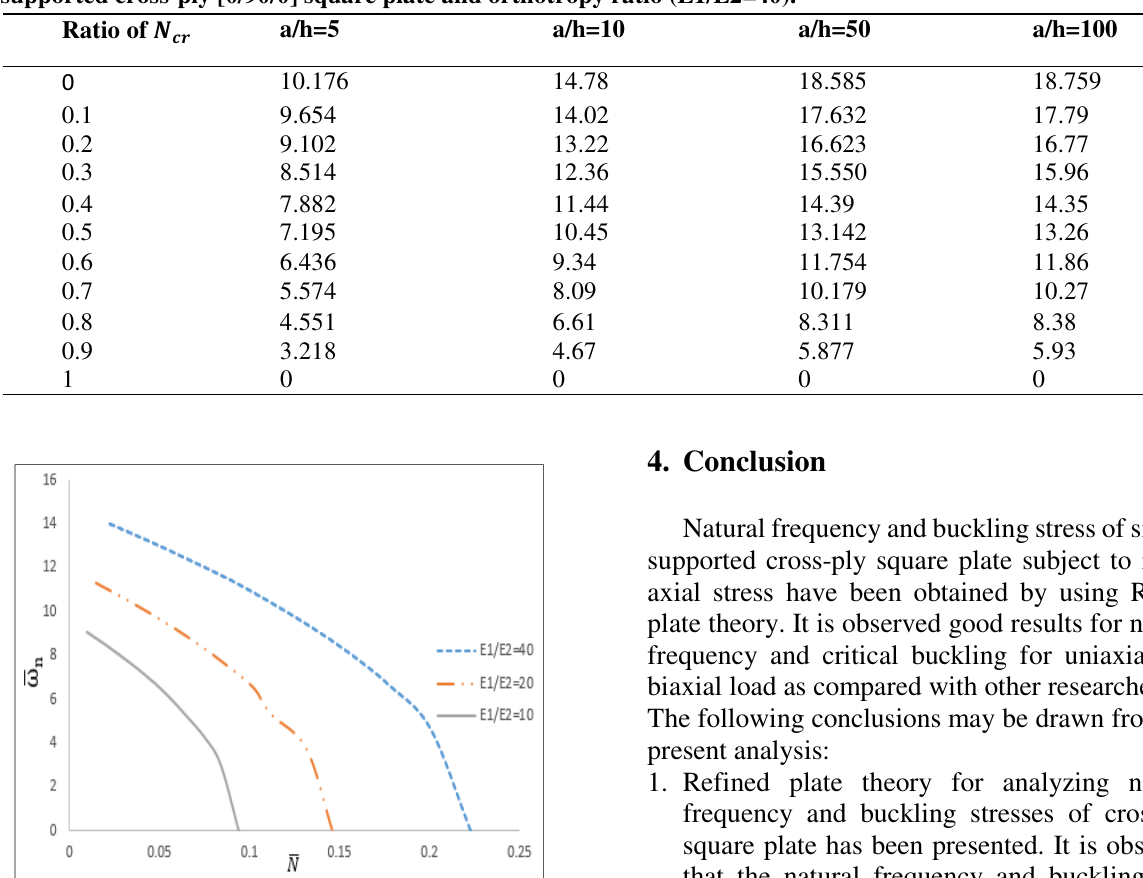
Non-dimensional natural frequency under various uniaxial loads ratio with various thickness ratio (a/h) for simply supported cross-ply [0/90/0] square plate and orthotropy ratio (E1/E2=40).